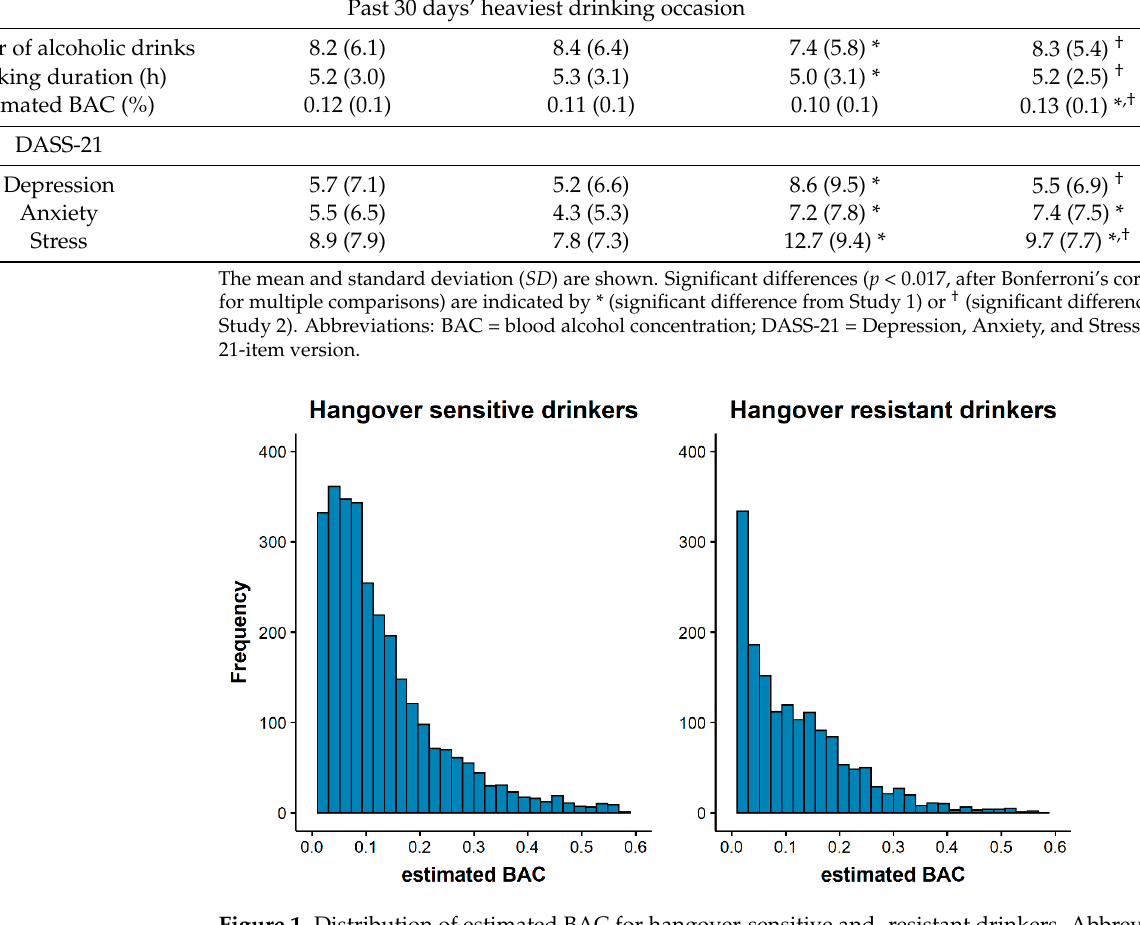
Figure 1. Distribution of estimated BAC for hangover-sensitive and -resistant drinkers. Abbreviation: estimated BAC = estimated blood alcohol concentration.